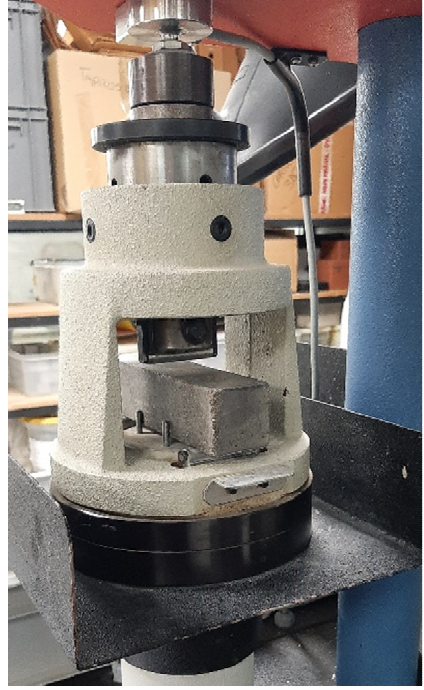
Figure 2. Hydraulic press used to determine compressive strength test.